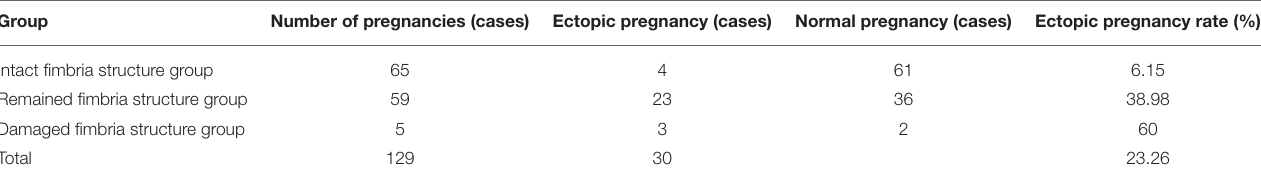
TABLE 8 | Fallopian tube fimbria structure and ectopic pregnancy.